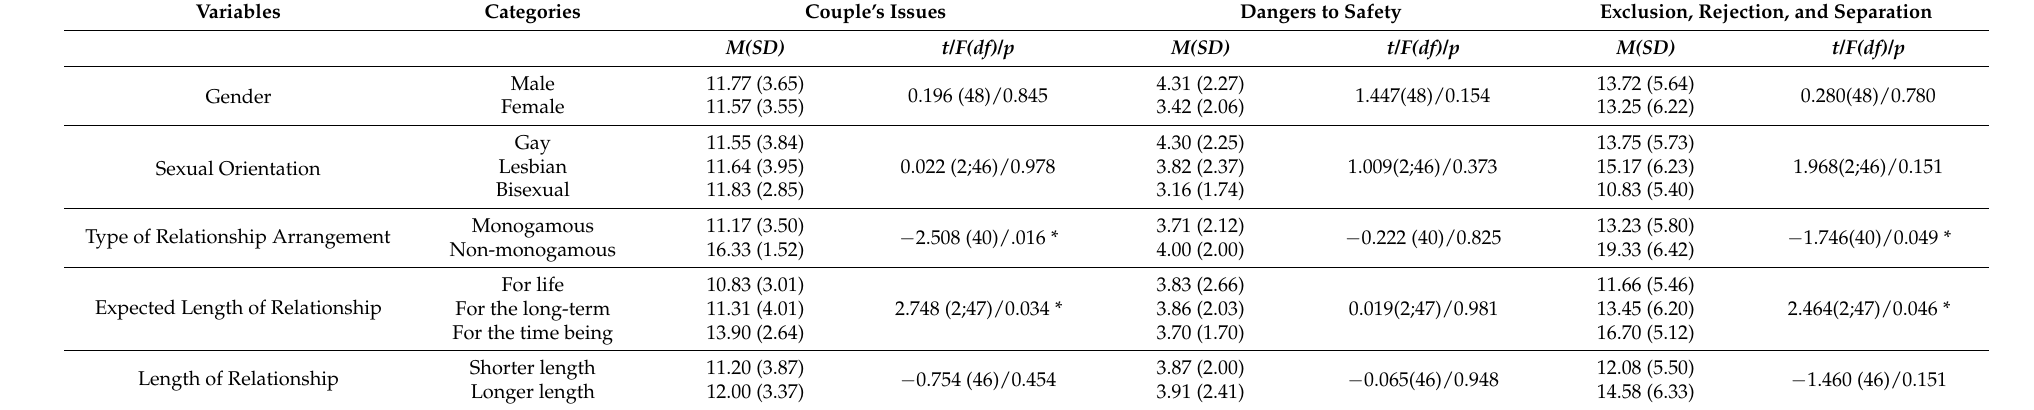
Table 4. Results for couple’s issues, dangers to safety and exclusion, rejection and separation by gender, sexual orientation and relationship characteristics. Variables